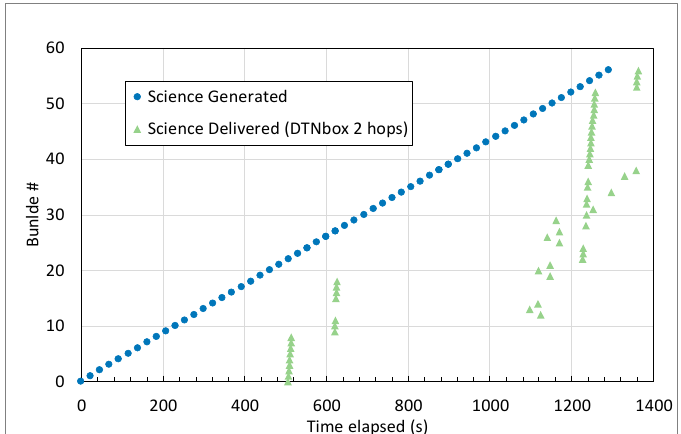
Figure 11. Science data flow (bulk priority), from Lander to PDGS: time sequences of bundle generation and delivery. Alternative delivery by means of DTNbox, but with a multilateral synchronization (Lander to ESA-MCC and ESA-MCC to PDGS hops).